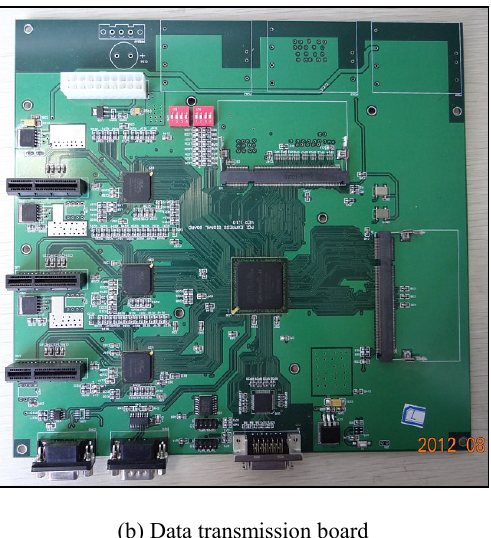
Figure 6. Data transmission board based on